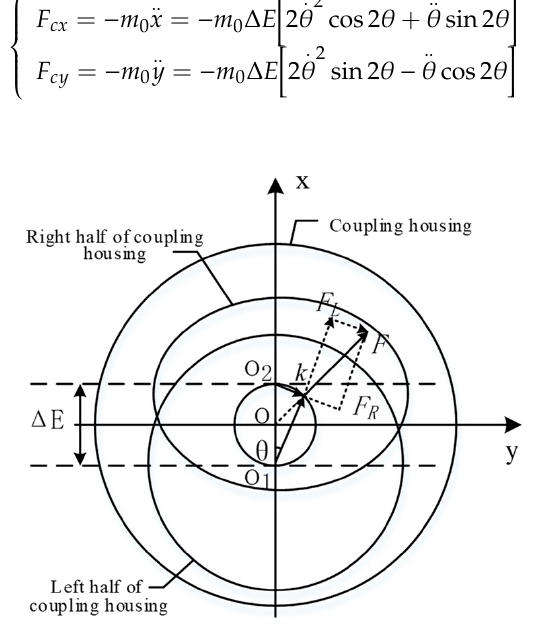
Figure 2. Schematic of relative movement for the coupling halves and housing.